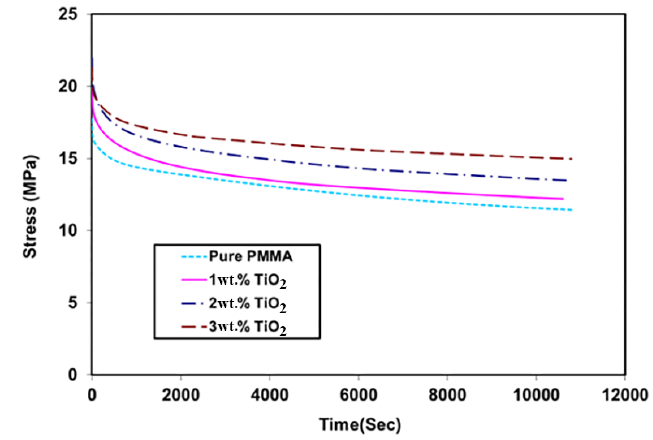
Figure 7. Relaxation behavior of PMMA and its nanocomposites (0 wt. %, 1 wt. %, 2 wt. %, and 3 wt. % TiO 2 NPs) at 1% strain.